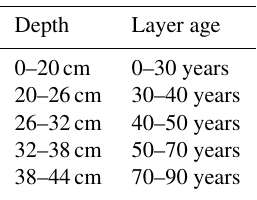
Table 1. Peat profile used to examine long-term carbon decomposi-